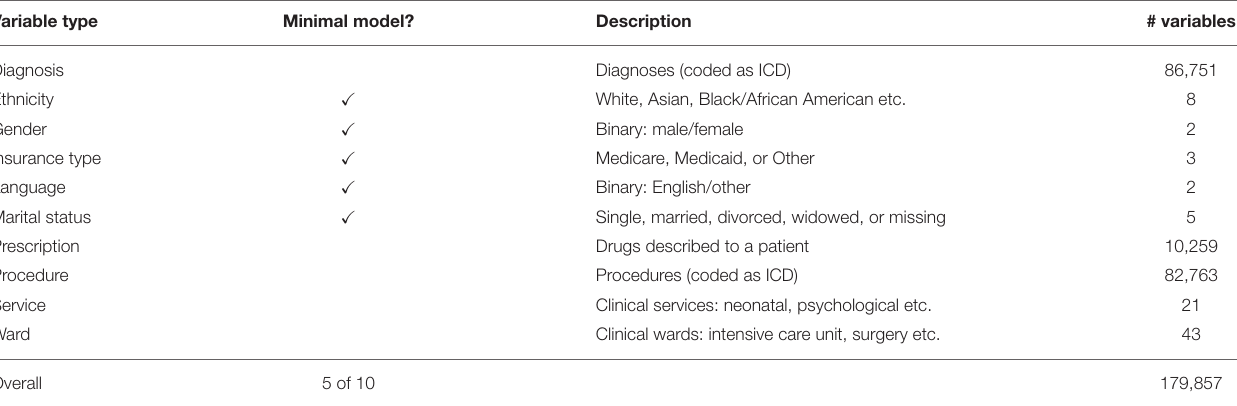
TABLE 1 | A list of all variables from MIMIC-IV that were used in this